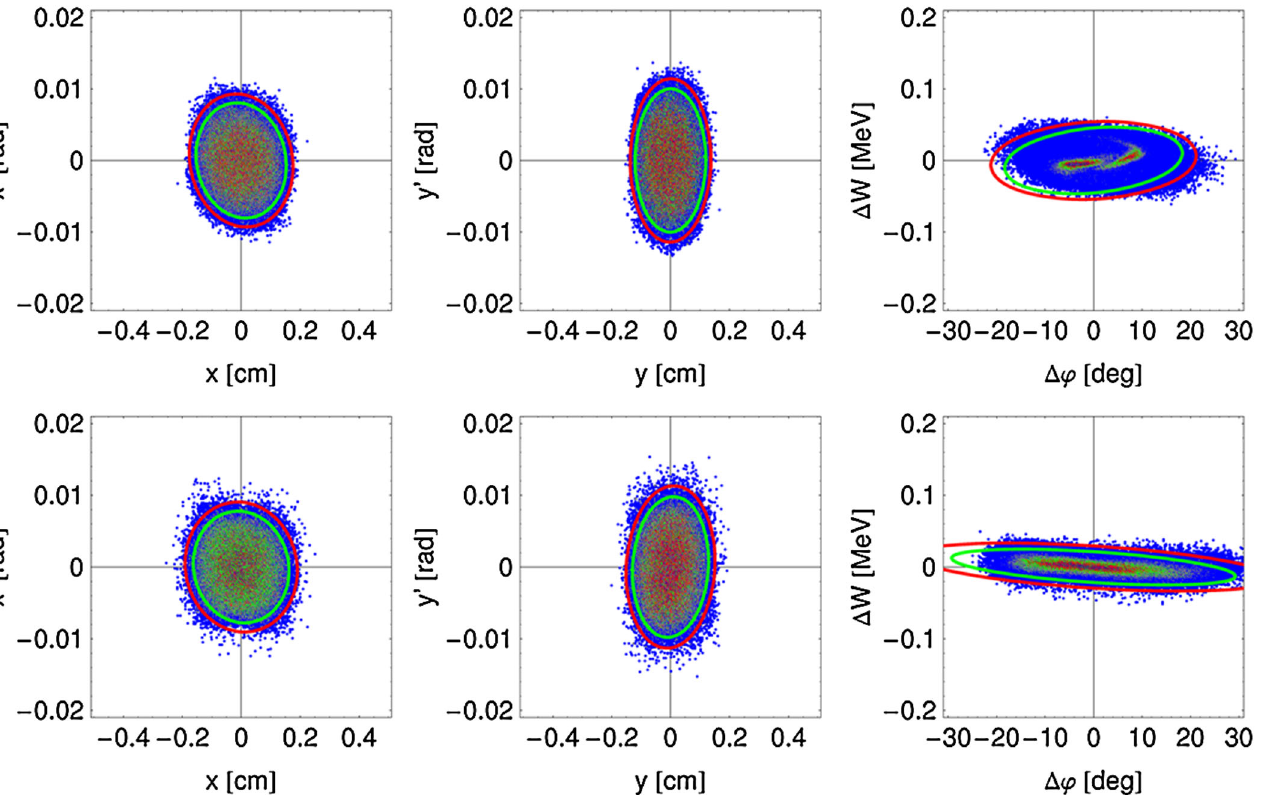
FIG. 7. (Color) RFQ output distributions with the red and green ellipses including 99% and 95% of transported particles, respectively (top: 5 mA; bottom: 30 mA).